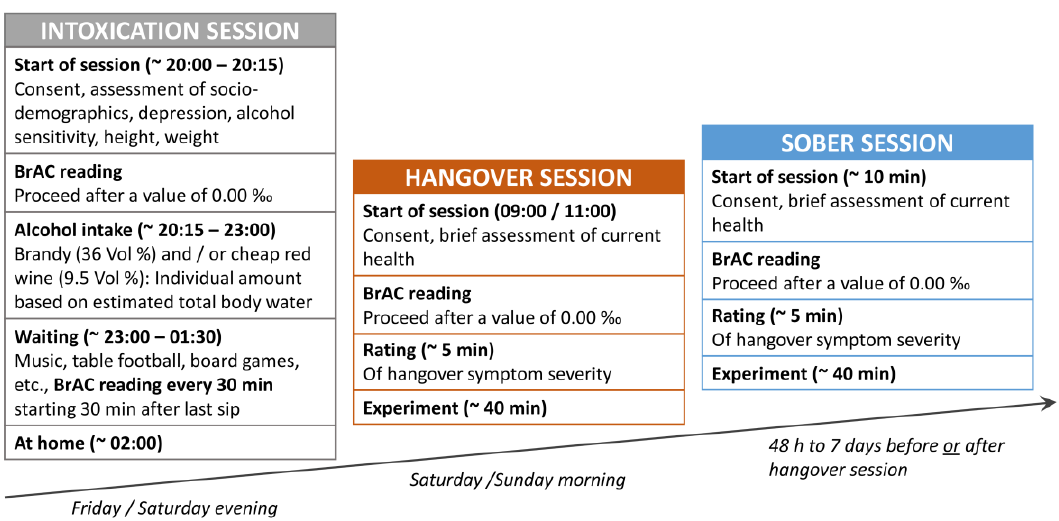
Figure 2. Outline of the intoxication, hangover, and sober sessions. Each participant was tested twice, once sober and once hungover, with a delay of a min. 48 h to max. 7 days between both sessions. The order of both sessions was counterbalanced across all participants. Written informed consent and a brief evaluation of the current health status was provided at the start of each session. Rating of hangover symptoms and recording of task performance was only started in case of a breath alcohol concentration (BrAC) of zero on both sessions. To induce alcohol hangover symptoms, participants were experimentally intoxicated at our laboratory on a Friday or Saturday evening starting from 20:00 (8 pm). Participants provided their written consent and completed questionnaires on sociodemographic data, height, weight, alcohol sensitivity, and depression. BrAC was measured before they started drinking to ensure sobriety. An individually-measured alcohol amount was consumed from approximately 20:15 to 23:00. BrAC was measured 30, 60, 90, and 120 min after the last alcoholic drink was finished. At around 01:30, participants were brought home via cab, given that their BrAC values were already declining, they had no impairments of consciousness, and no major walking / coordination impairments. Participants came back to the laboratory in the next morning between 09:00 and 11:00 to complete their hangover